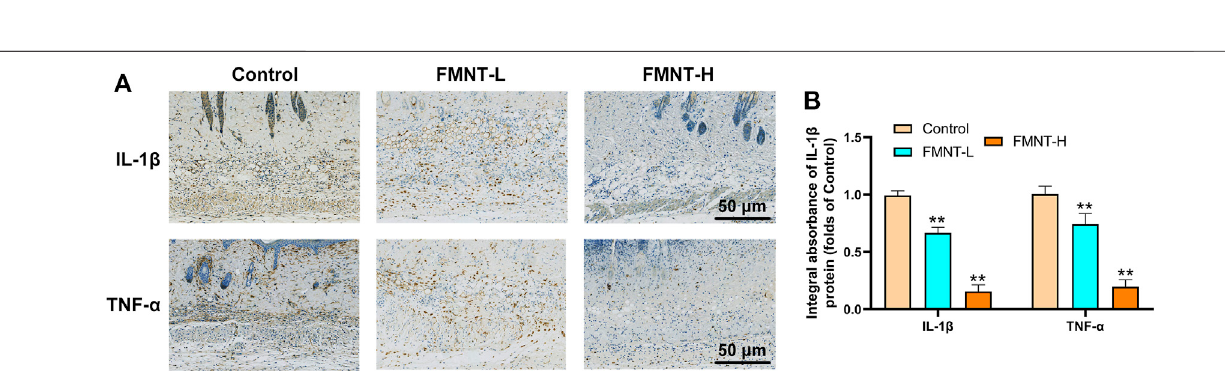
FIGURE 2 | FMNT ameliorated oxidative stress in the random pattern skin fl aps (A) The activities of SOD among three groups (B) Average GSH-Px activities in rat skin fl ap tissue. All data represent mean ± SD. ** p ≤ 0.01 compared to the control group.